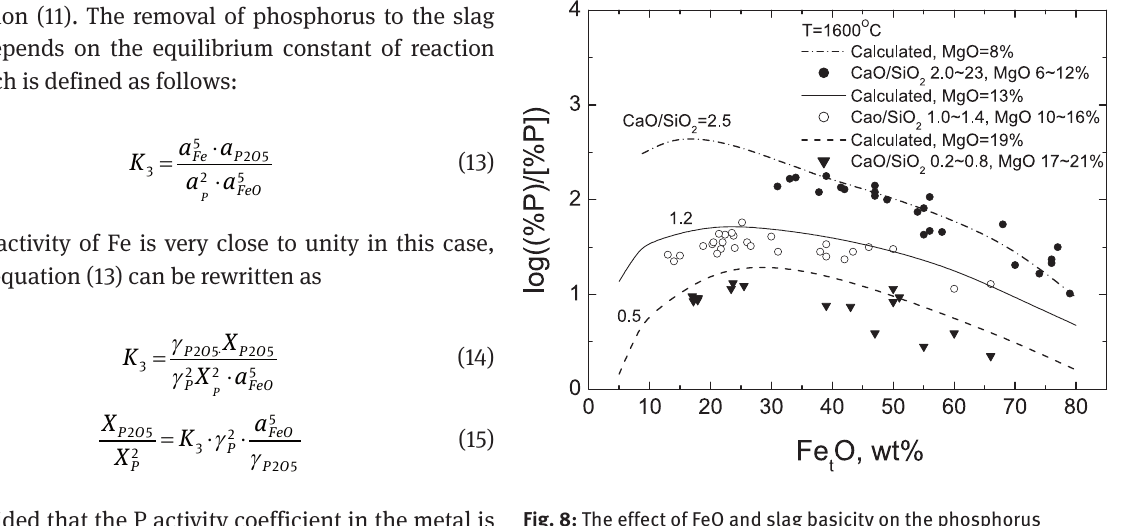
slag [16–19] and metal. 2